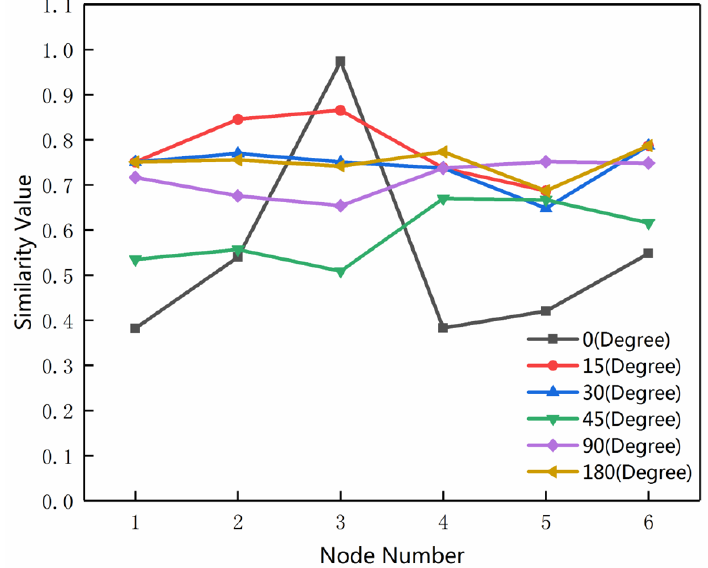
Figure 23. Similarity curve of six pairs of elements with the same name under di ff erent rotation angles Figure 23. S imilarity curve of six pairs of elements with the same name under different rotation after iterative relaxation iteration by using PRM. angles after iterative relaxation iteration by using PRM.